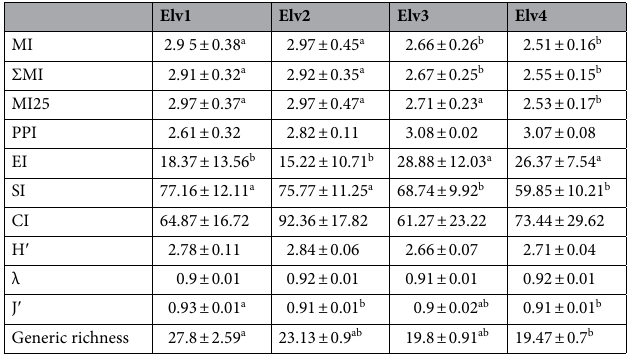
Table 2. Soil nematode community indices across elevation classes. Means followed by different superscript letters reflects significant differences by the post hoc-test ( p < 0.05).